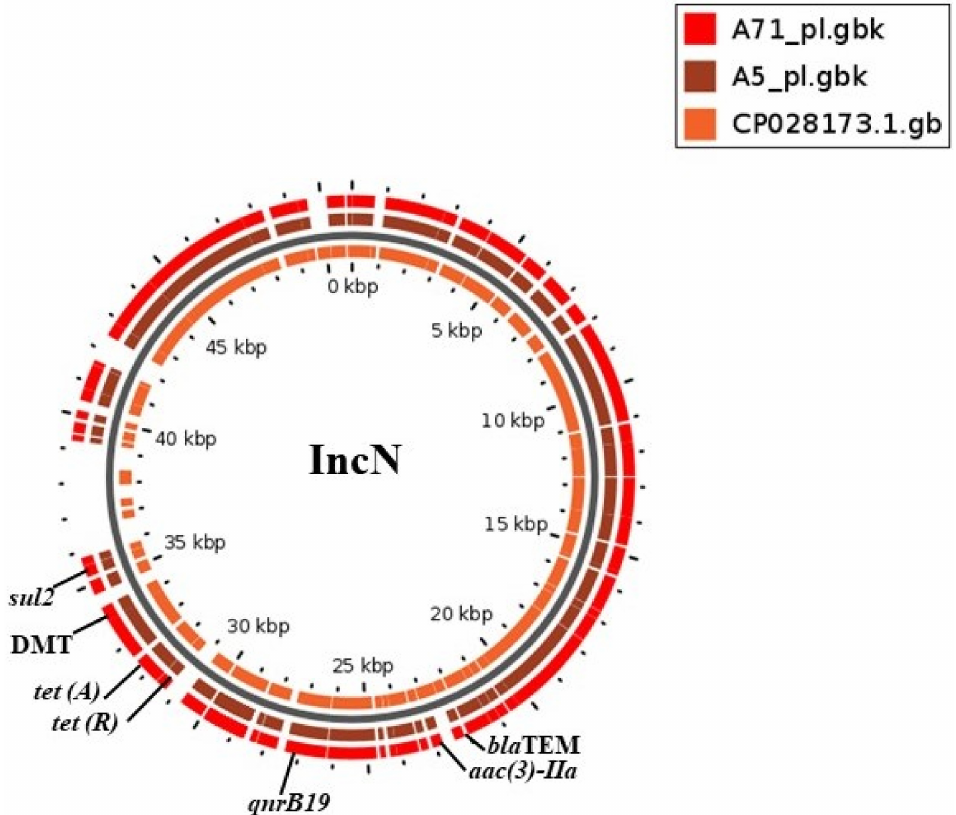
Figure 1. BLAST atlas created using GView of two plasmids from S . Schwarzengrund carrying multidrug resistance genes with the reference plasmid CP028173.1. The innermost ring represents the genes of the reference plasmid, while the two outermost rings are the query plasmids from this study. Genomic locations of resistance genes are